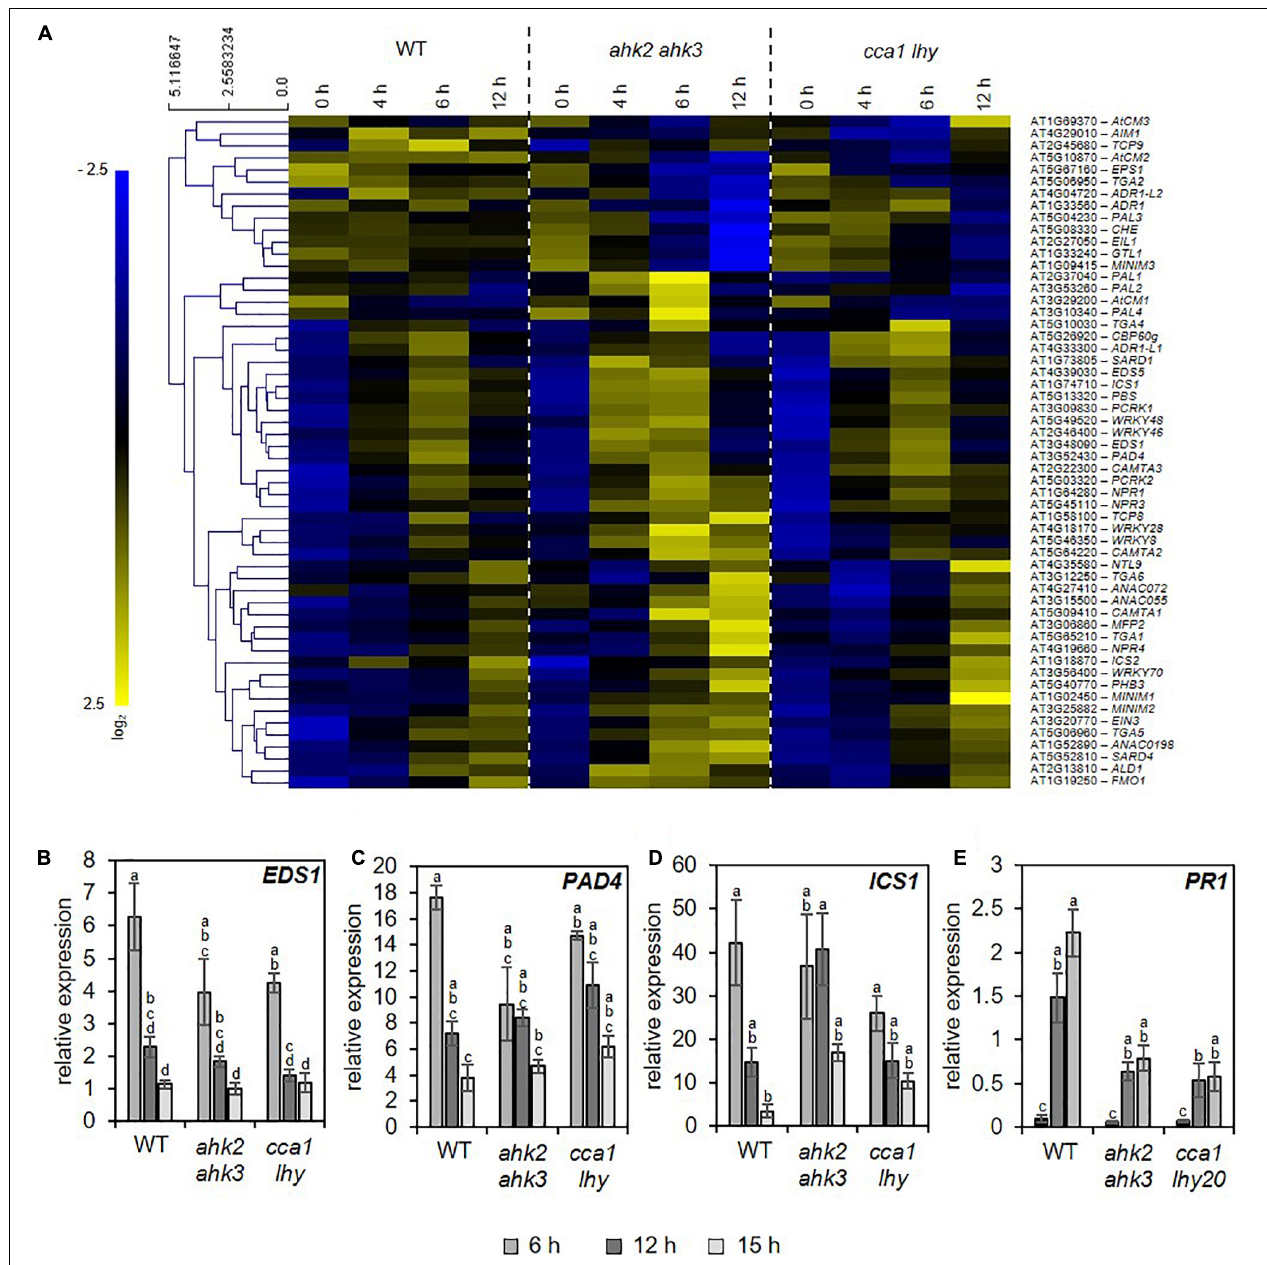
FIGURE 6 | Photoperiod stress results in transcriptional regulation of salicylic acid biosynthesis and signaling. (A) Hierarchical clustering of genes involved in salicylic acid (SA) biosynthesis and signaling (Pearson’s correlation). An overview of the regulation of these signaling genes after photoperiod stress treatment is provided in Supplementary Data 8 . (B–E) Relative expression of EDS1 (B) , PAD4 (C) , ICS1 (D) and PR1 (E) in WT, ahk2 ahk3 and cca1 lhy plants during the night following the 32 h prolonged light period (PLP) measured by qRT-PCR. All values are expressed relative to 0 h WT control which was set to 1. Error bars represent SE ( n ≥ 3). Letters indicate different statistical groups ( p ≤ 0.05) determined by ANOVA followed by Tukey’s post-hoc